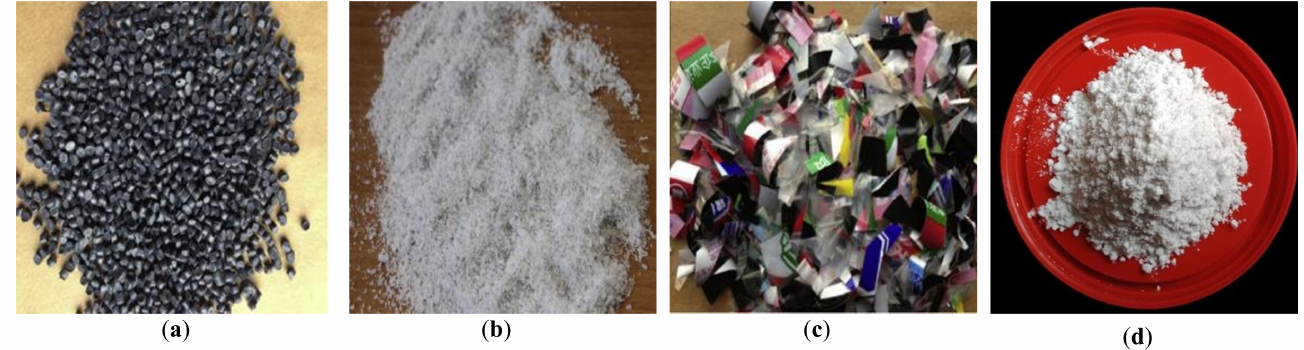
Figure 2. Various forms of waste plastics used as modifiers: ( a ) pellet [57]; ( b ) shredding [54]; ( c ) flake [57]; ( d ) powder [58]. Reprinted with permission from Refs. [54,57,58]. Copyright 2014 Elsiver